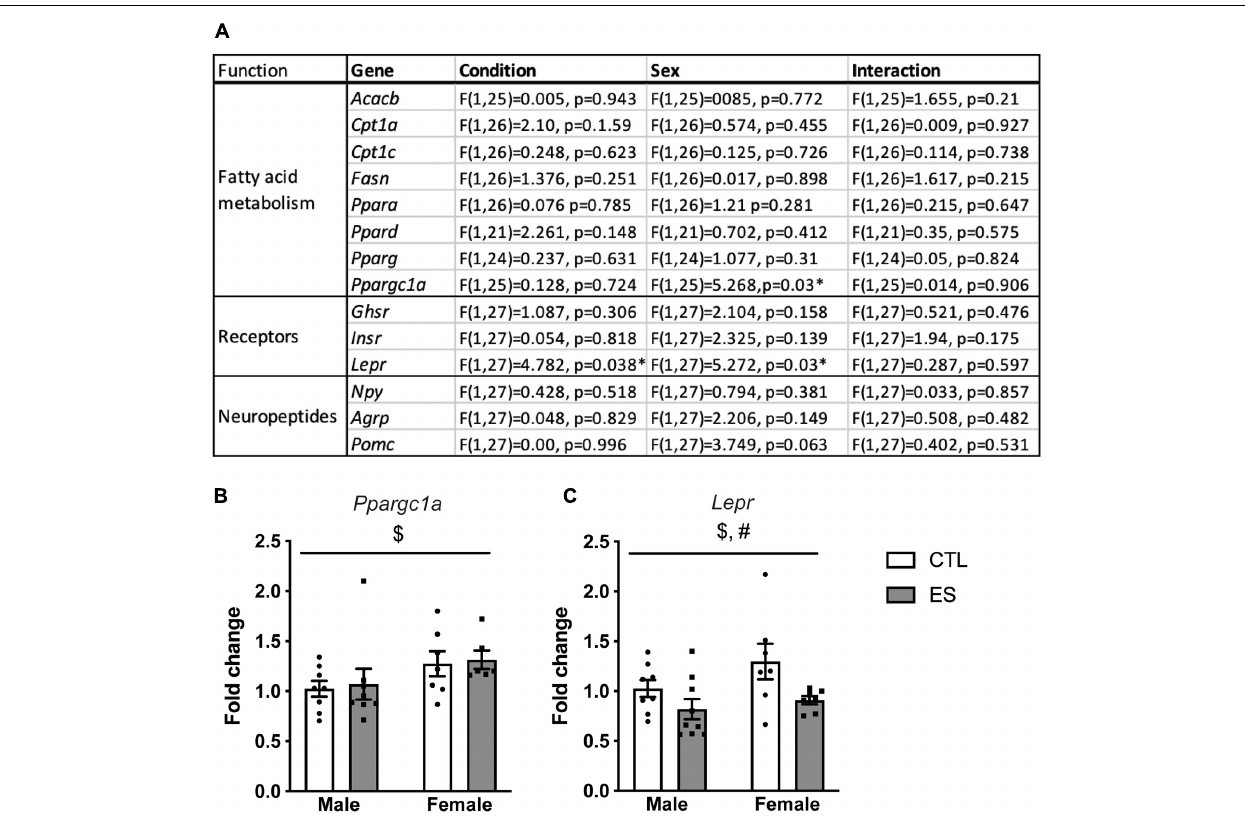
FIGURE 1 | (A) Effects of ES and sex on hypothalamic gene expression at P9. (B) Hypothalamic Ppargc1a expression was higher in females. (C) Lepr expression was higher in females and lower in ES-exposed animals. Indicated is mean ± SEM, p < 0.05. # Main effect of condition; * = significant effect; $ main effect of